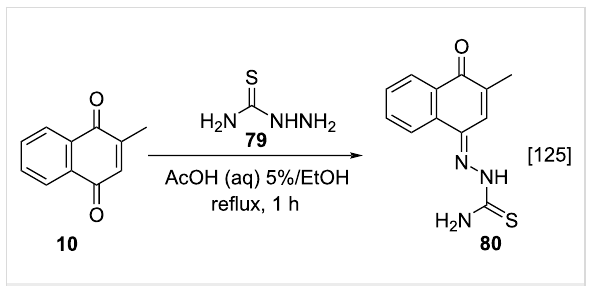
Scheme 25: Condensation reaction of menadione with thiosemicar-